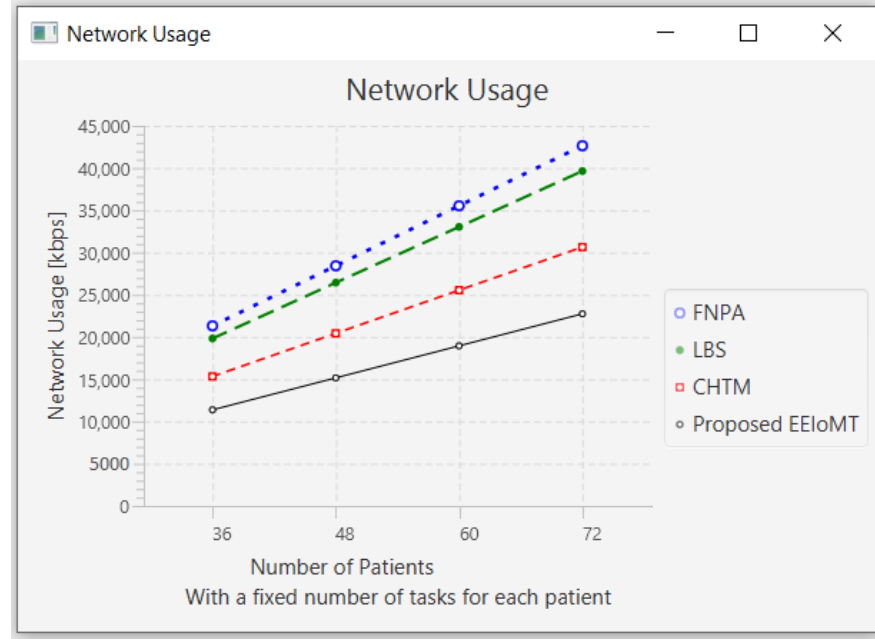
Figure 9. Average energy consumption comparison when changing the number of patients.